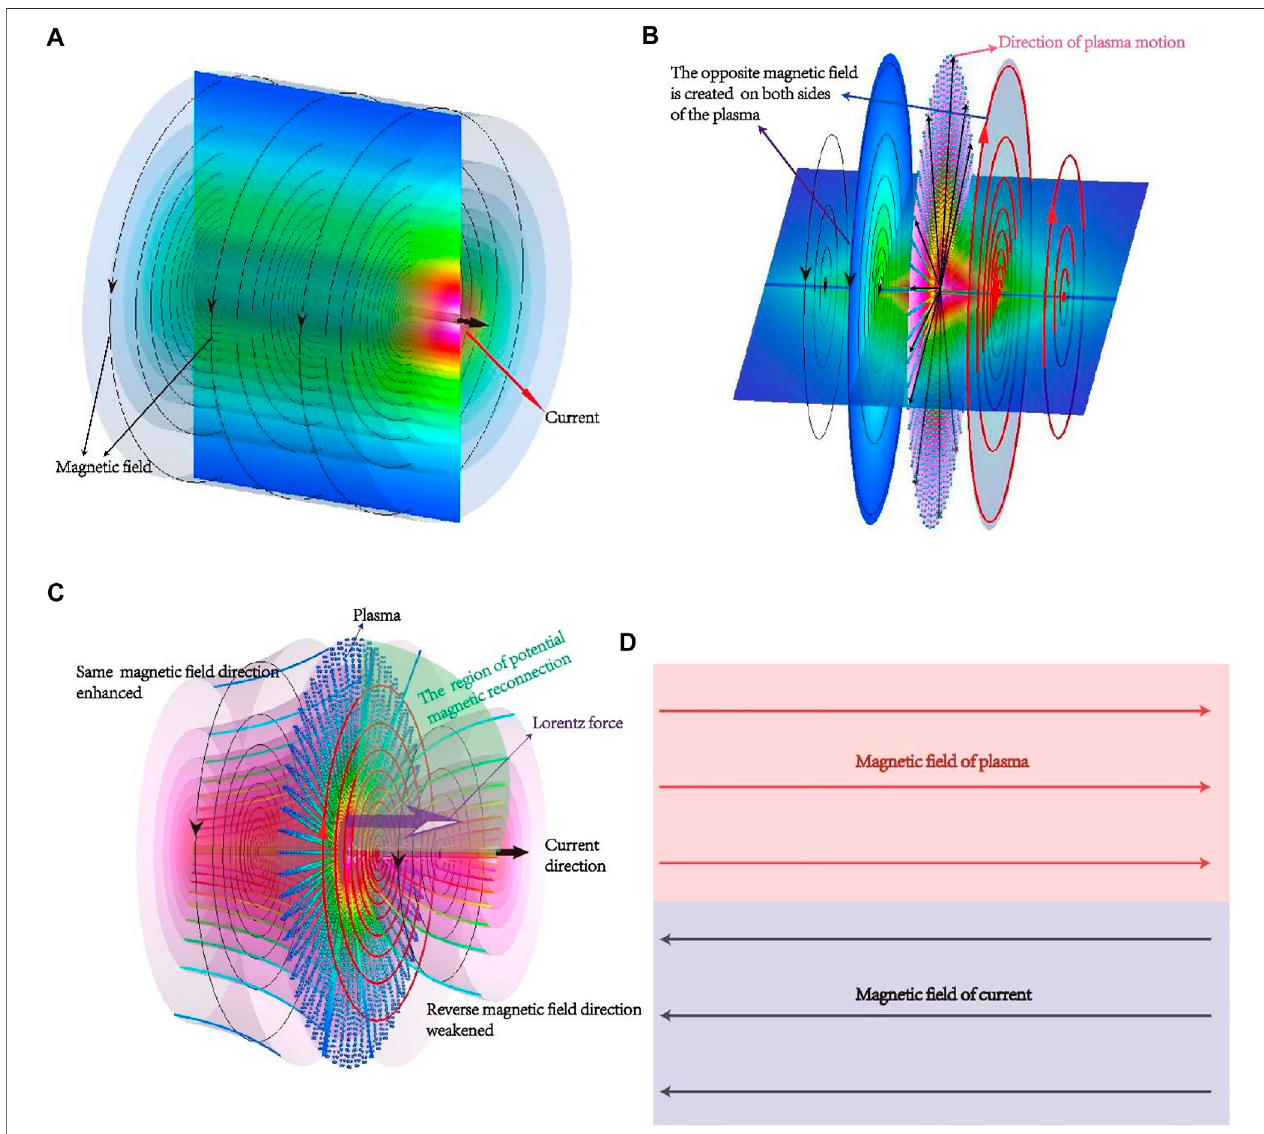
FIGURE 5 | Schematic diagram of the formed magnetic fi eld of electrical explosion. (A) The counter-clockwise toroidal magnetic fi eld formed by the axial current. (B) The plasma and the magnetic fi eld it creates in the electrical explosion; the direction of the magnetic fi eld is opposite on both sides of the plasma. (C) Three- dimensional magnetic fi eld topological map obtained by superimposing the image (A, B) . (D) The distribution of the magnetic lines of force on the slice plane of the inverted magnetic fi eld region, and this slice plane is parallel to the direction of plasma motion.